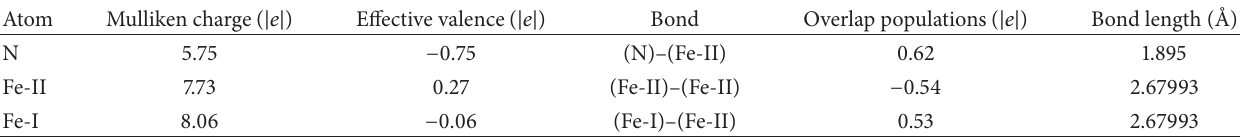
Table 2: Atomic Mulliken charges and overlap population of bonds in 𝛾 󸀠 -Fe 4 N at 𝑎 = 3.772 ˚A.